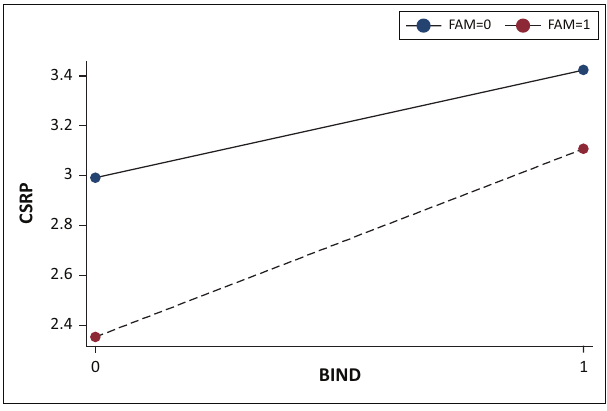
FIGURE 1: Moderating effect of family on board independence and corporate social responsibility performance relationship. Bind, board independence; CSRP, corporate social responsibility